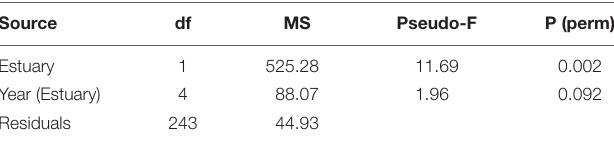
TABLE 1 | Permutational Multivariate Analysis of Variance (PERMANOVA) analysis results on cockle abundance in the Tagus and Sado estuaries, in 2015, 2018, and